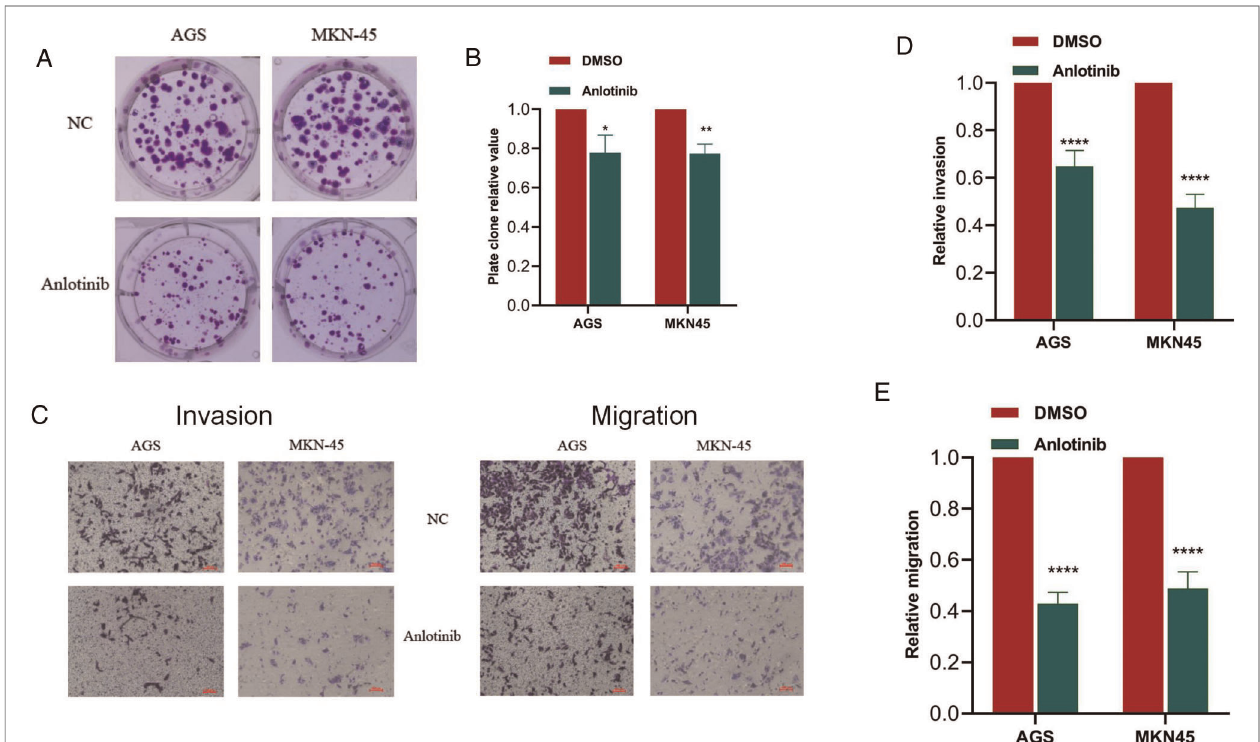
FIGURE 5 | Anlotinib can signi fi cantly inhibit the proliferation, migration and invasion of GC cells. ( A,B ) Plate cloning assays proved that Anlotinib can signi fi cantly inhibit the proliferation of GC cells. ( C - E ) The results of transwell migration and invasion assays proved that Anlotinib can inhibit the migration and invasion of